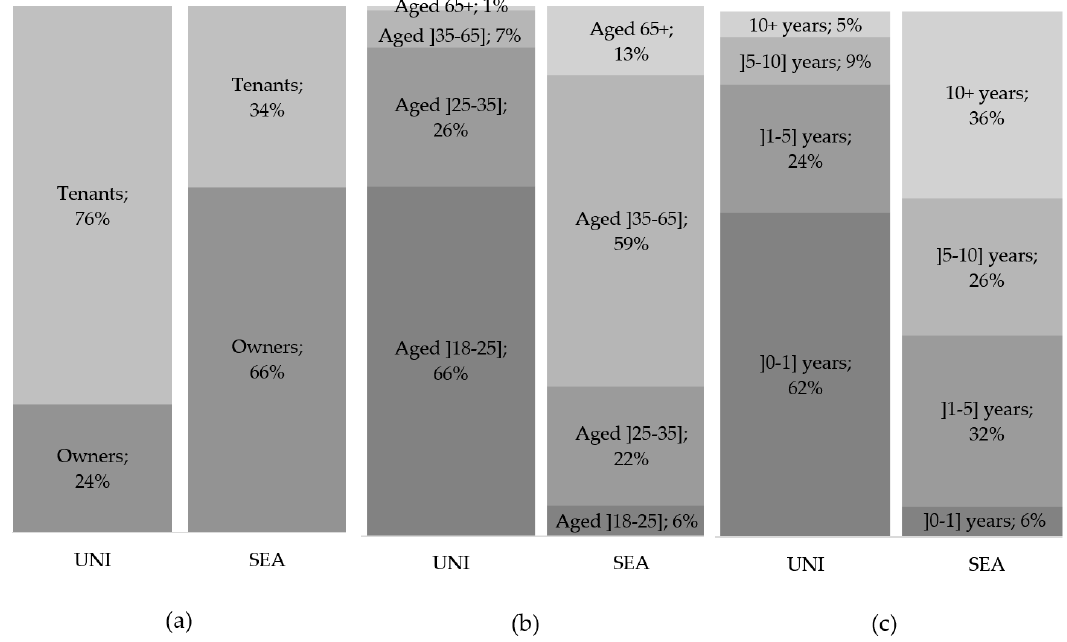
Figure 4. The two sets of buildings were selected in order to provide two samples of occupants with utterly diverging distributions of three essential features: ( a ) Ownership; ( b ) Occupant’s age; ( c ) Time of occupancy.